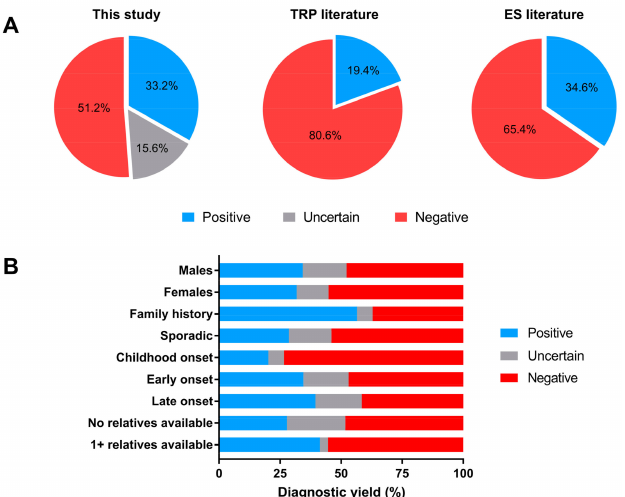
Figure 2. ( A ) Overall diagnostic yield achieved in this study compared with average results of TRP and ES approaches as described in the literature; ( B ) Diagnostic yield presented by specific